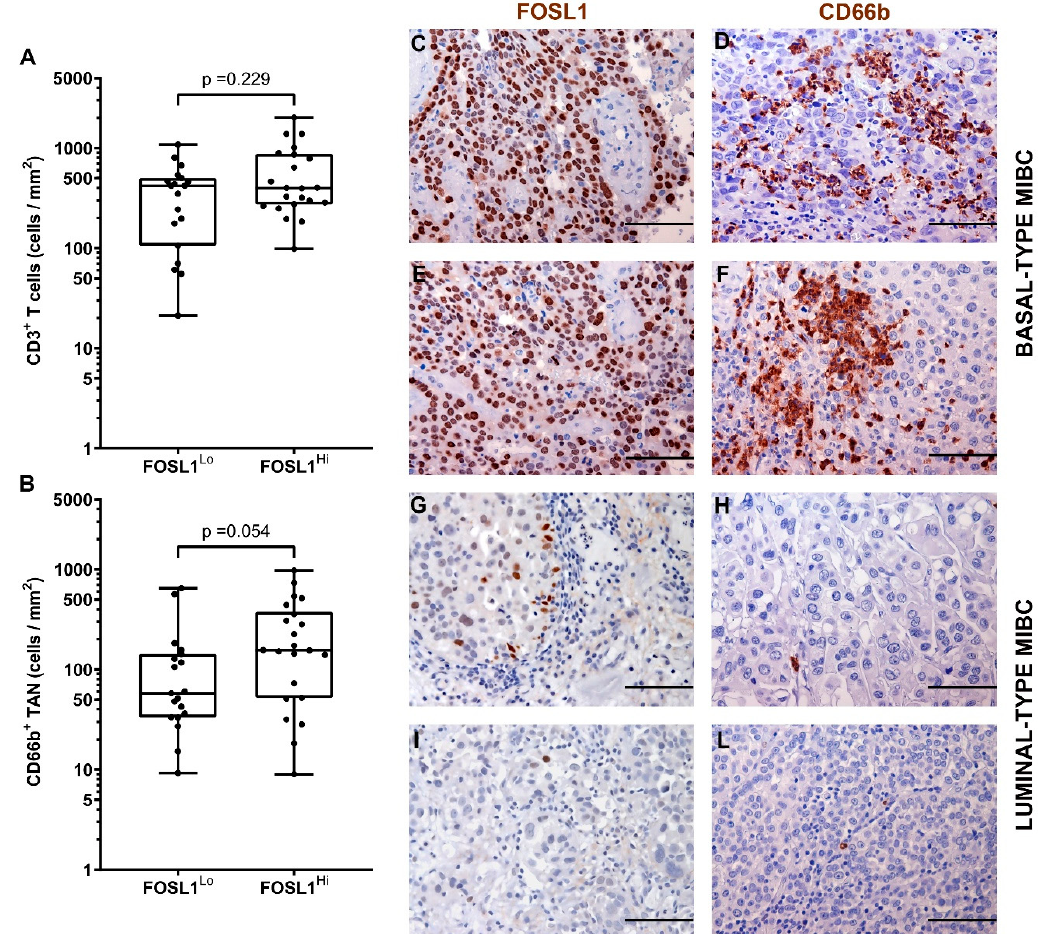
Figure 7. Density of CD66b + TAN and CD3 + T cells in MIBC in relation to FOSL1 expression. Dot plots indicating the density of CD3 + T cells ( A ) and CD66b + TAN ( B ) in the MIBC cohort based on FOSL1 expression. Sections are from two FOSL1 HIGH (case 49 and 14, in C – F ) and two FOSL1 LOW (case 68 and 23, in G – L ) MIBC cases and stained as labeled and counterstained with hematoxylin. Magnification: 200× ( C – L ), scale bar 100 micron. p values were estimated by Kruskal-Wallis test.